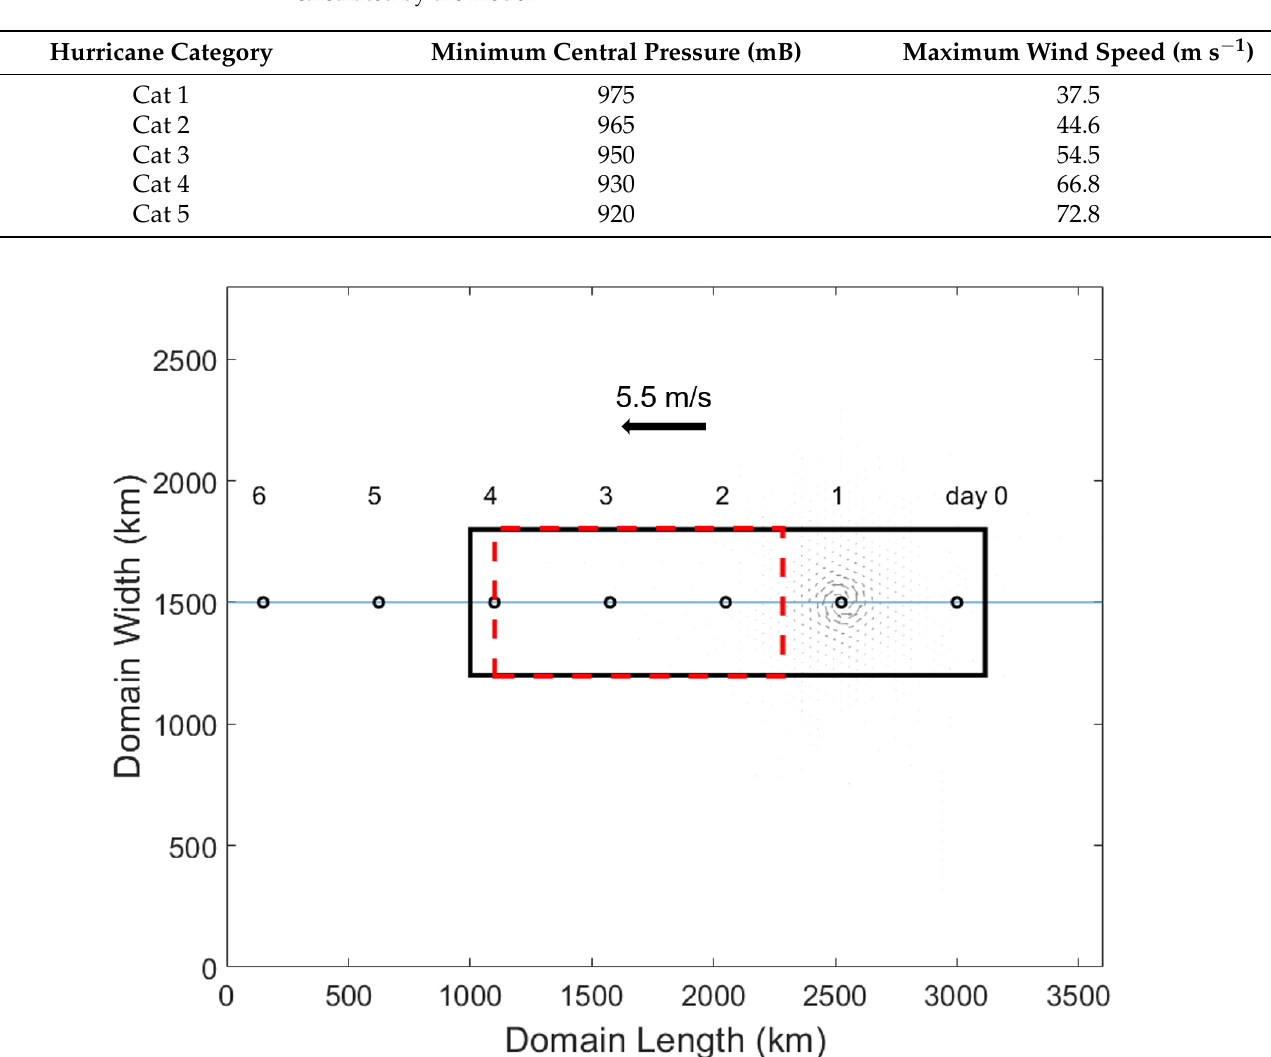
Table 1. Minimum central pressure (mB) and maximum wind speed (m s − 1 ) for each hurricane category. Minimum central pressure is user-defined in the Holland wind model, while wind speed is calculated by the model.